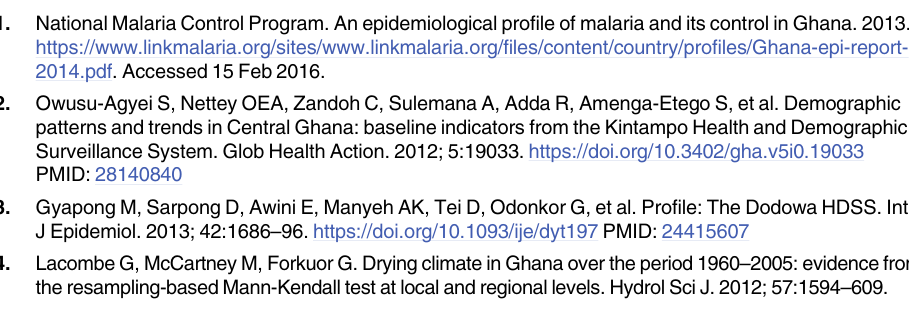
S3 Fig. Patterns of aggregated cases of malaria attributable deaths for the (a) Guinea savannah, (b) Transitional forest, (c) Coastal savannah by month for 2008 to 2015. S4 Fig. Seasonal, trend and remainder (residuals from both season and trend) of the decomposed uncomplicated malaria data series by LOESS for the Guinea savannah zone. S5 Fig. Seasonal, trend and remainder (residuals from both season and trend) of the decomposed uncomplicated malaria data series by LOESS for the Transitional forest zone. S6 Fig. Seasonal, trend and remainder (residuals from both season and trend) of the decomposed uncomplicated malaria data series by LOESS for the Coastal savannah zone. S1 Dataset. Minimal clinical dataset of uncomplicated malaria cases by year, month and